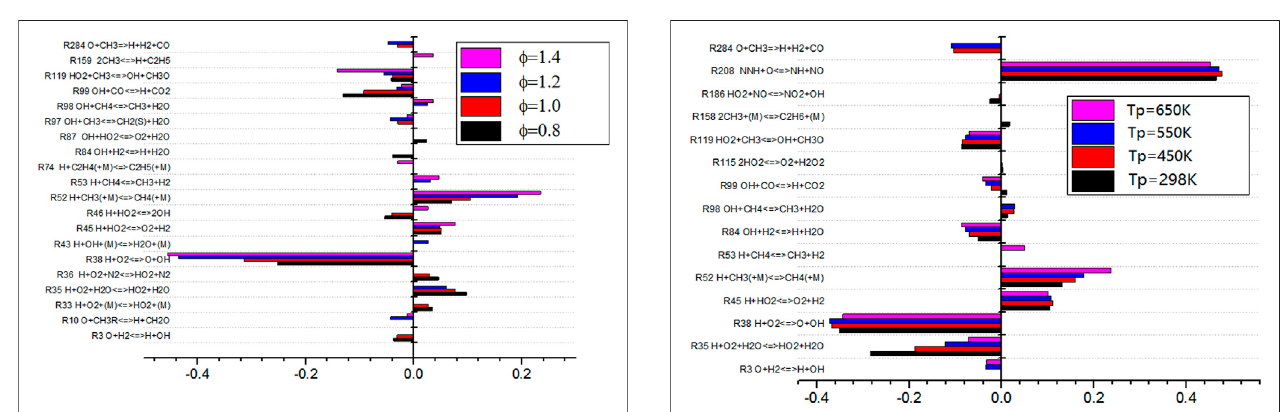
FIGURE 12 | Sensitivity analysis of equivalence ratio to combustion temperature. FIGURE 13 | Sensitivity analysis of preheating temperature to NO